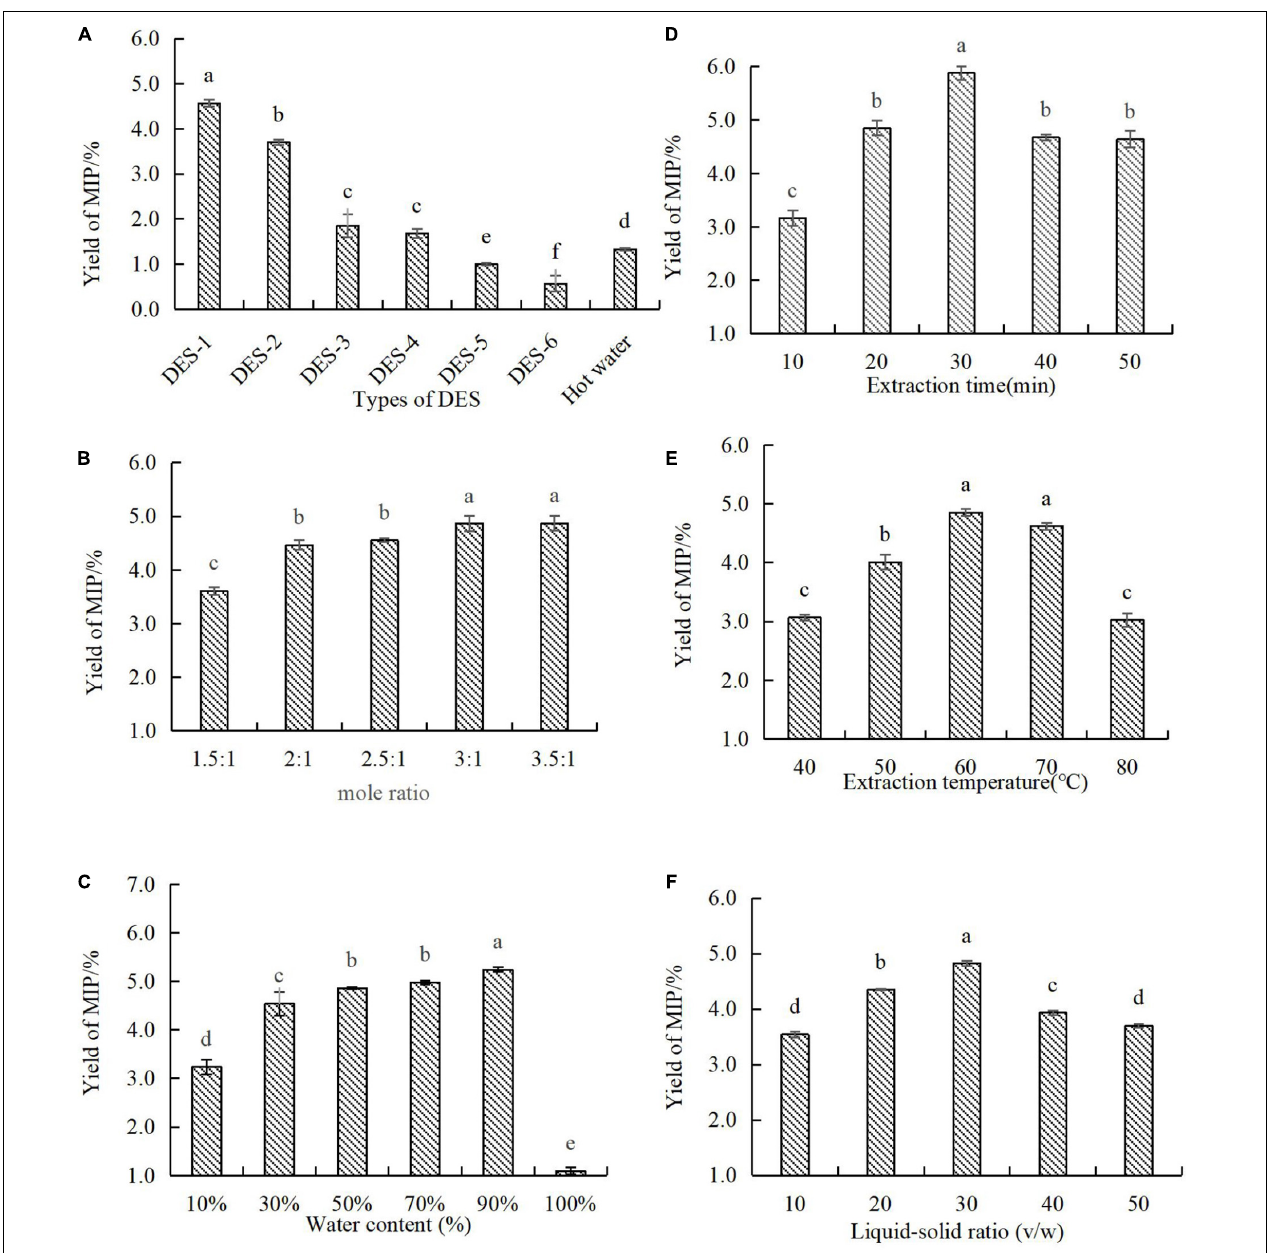
FIGURE 1 | Effect of different extraction parameters in the extraction yield of MIP-D. (A) Types of DESs, (B) mole ratio, (C) water content, (D) extraction time, (E) extraction temperature, and (F) ratio of liquid–solid. Data represent means ± SD ( n = 3). Significant ( p < 0.05) differences are shown by data bearing different letters